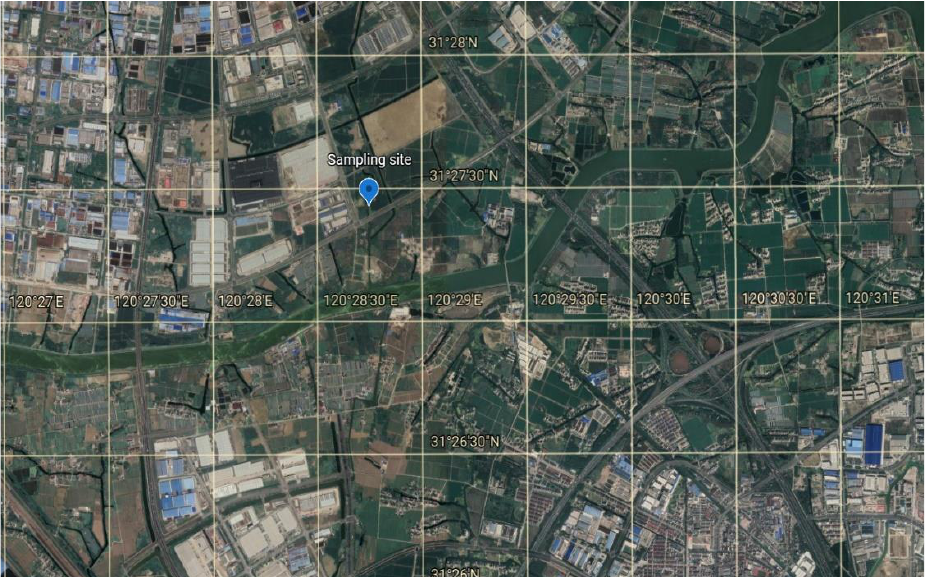
Figure 1. Sampling site in the riparian zone of a tributary of Wangyu River.